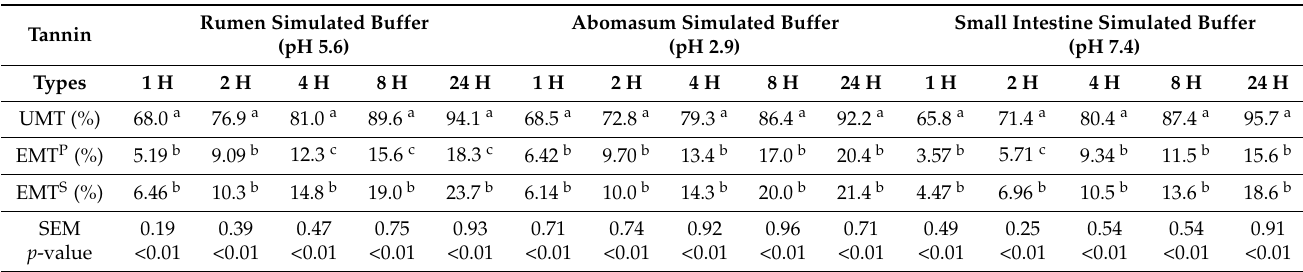
Table 1. In vitro release rate of unencapsulated mimosa tannin or tannins encapsulated with palm and sunflower oils in GIT simulated media. Rumen Simulated Buffer Tannin (pH